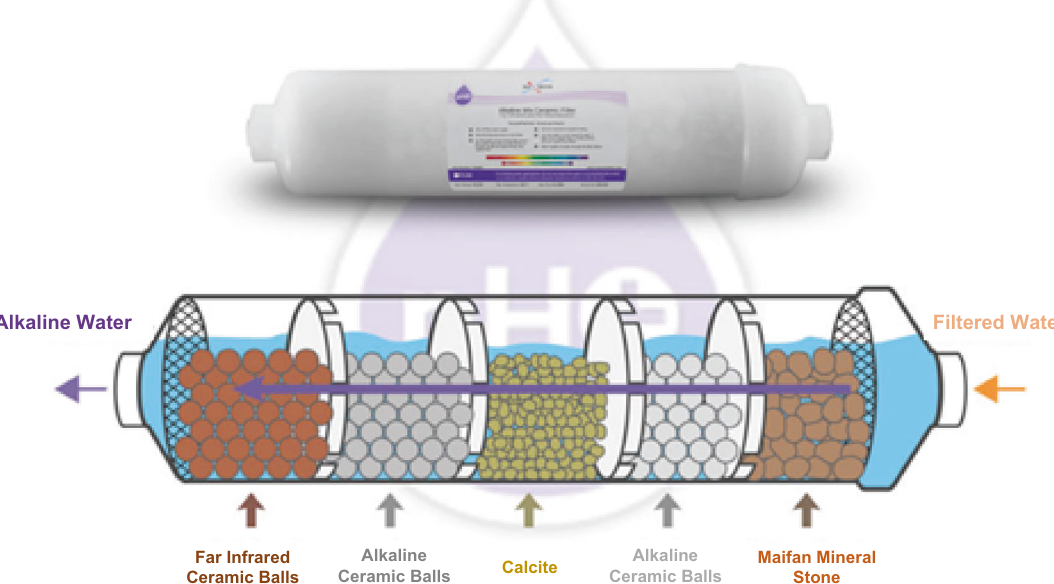
Fig. 7 Schematic of 5-in-1 remineralization fi lter. Remineralization aims to adjust the alkalinity of RO- fi ltered water by re-introducing healthy minerals; tap water RO permeate is de fi cient in healthy minerals, has a slightly dry, burning feeling to the tongue, and is slightly corrosive with pH < 6.0 (reprinted with permission from 108 ; Copyright © EZFILTER,